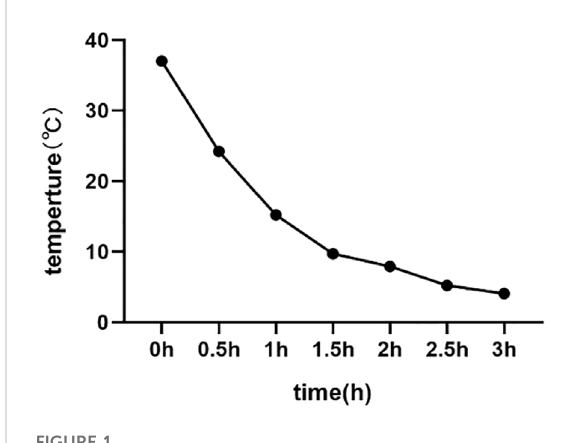
FIGURE 1 The cooling curve during buck semen